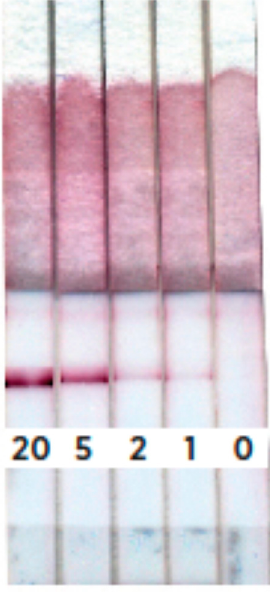
Figure 9. Appearance of the test strips for samples containing 20%, 5%, 2%, and 1% of minced beef meat added to minced chicken meat ( n = 3).